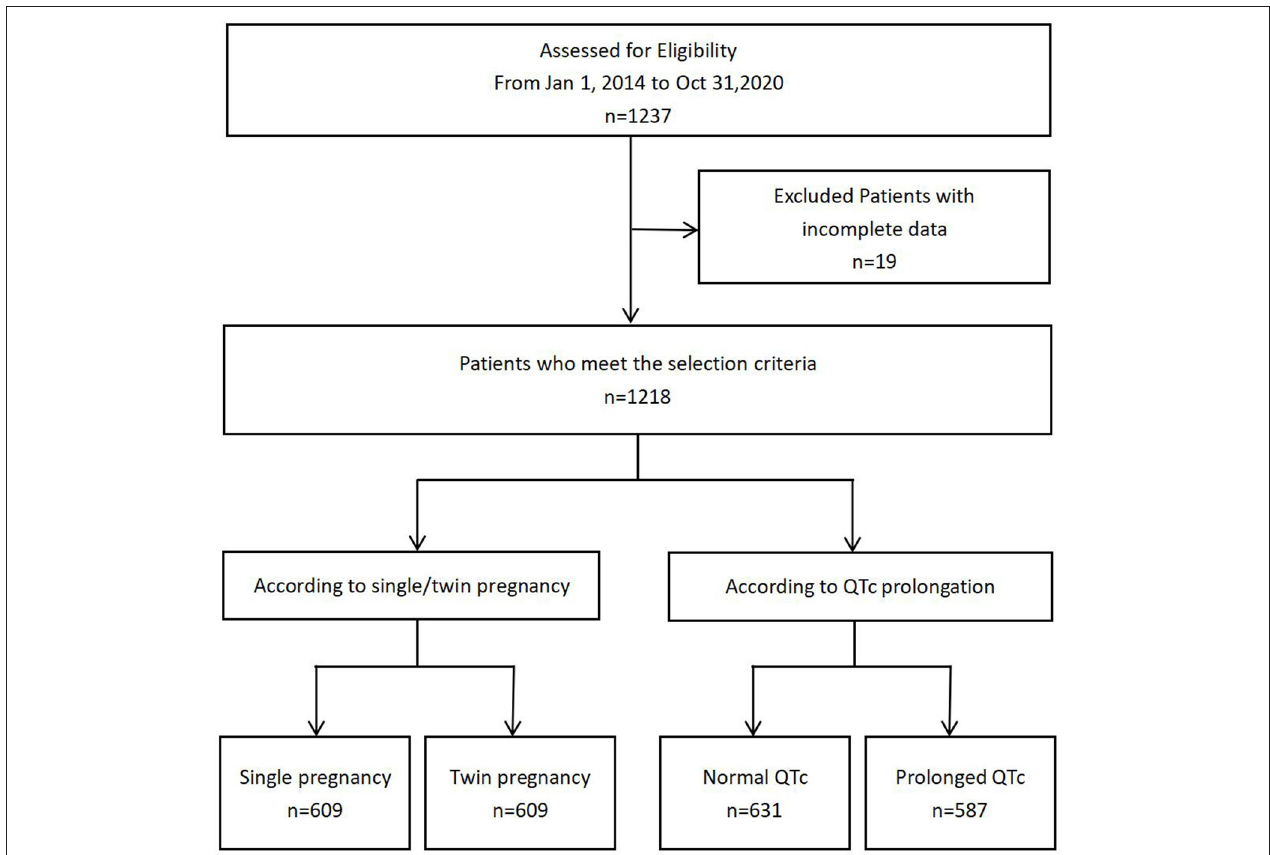
FIGURE 1 | Flow diagram demonstrating patient inclusion and study